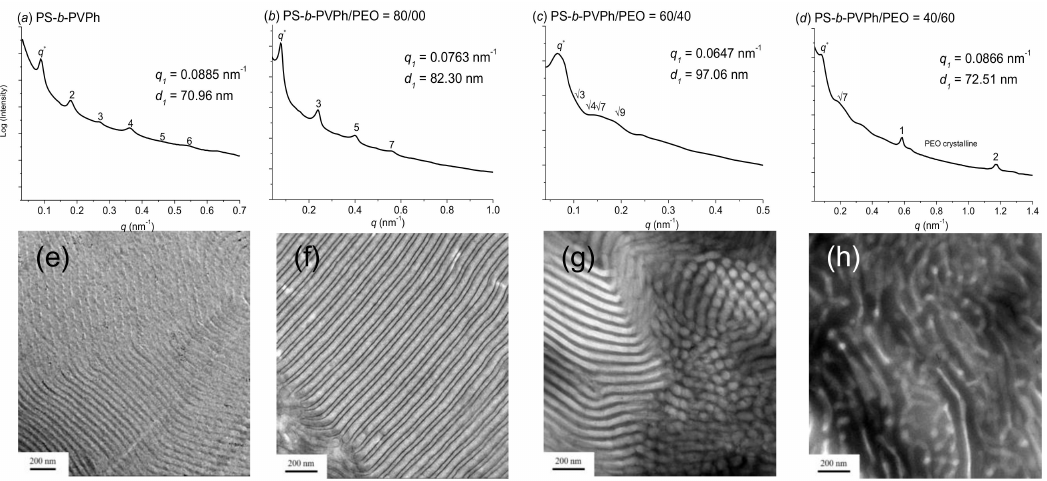
Figure 4. SAXS and TEM images of PS- b -PVPh/PEO blends of ( a , e ) 100/0, ( b , f ) 80/20, ( c , g ) 60/40, and ( d , h )